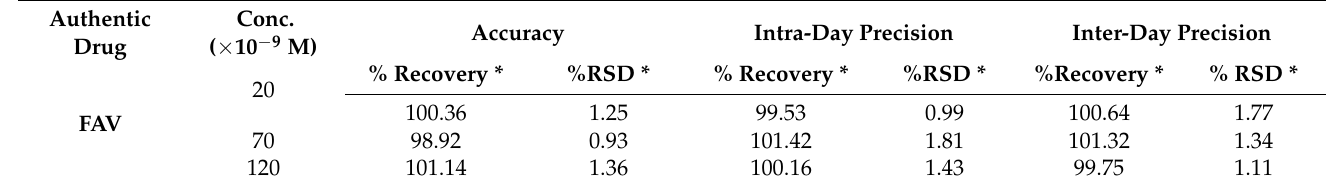
Table 2. Accuracy and precision results for determination of FAV under the developed SWV method.